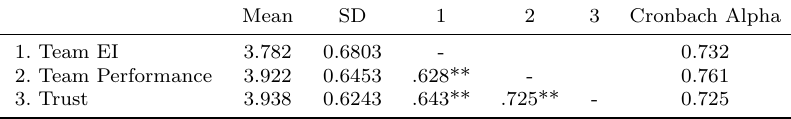
Table 1: Mean, standard deviations and correlation of all variables Mean SD 1